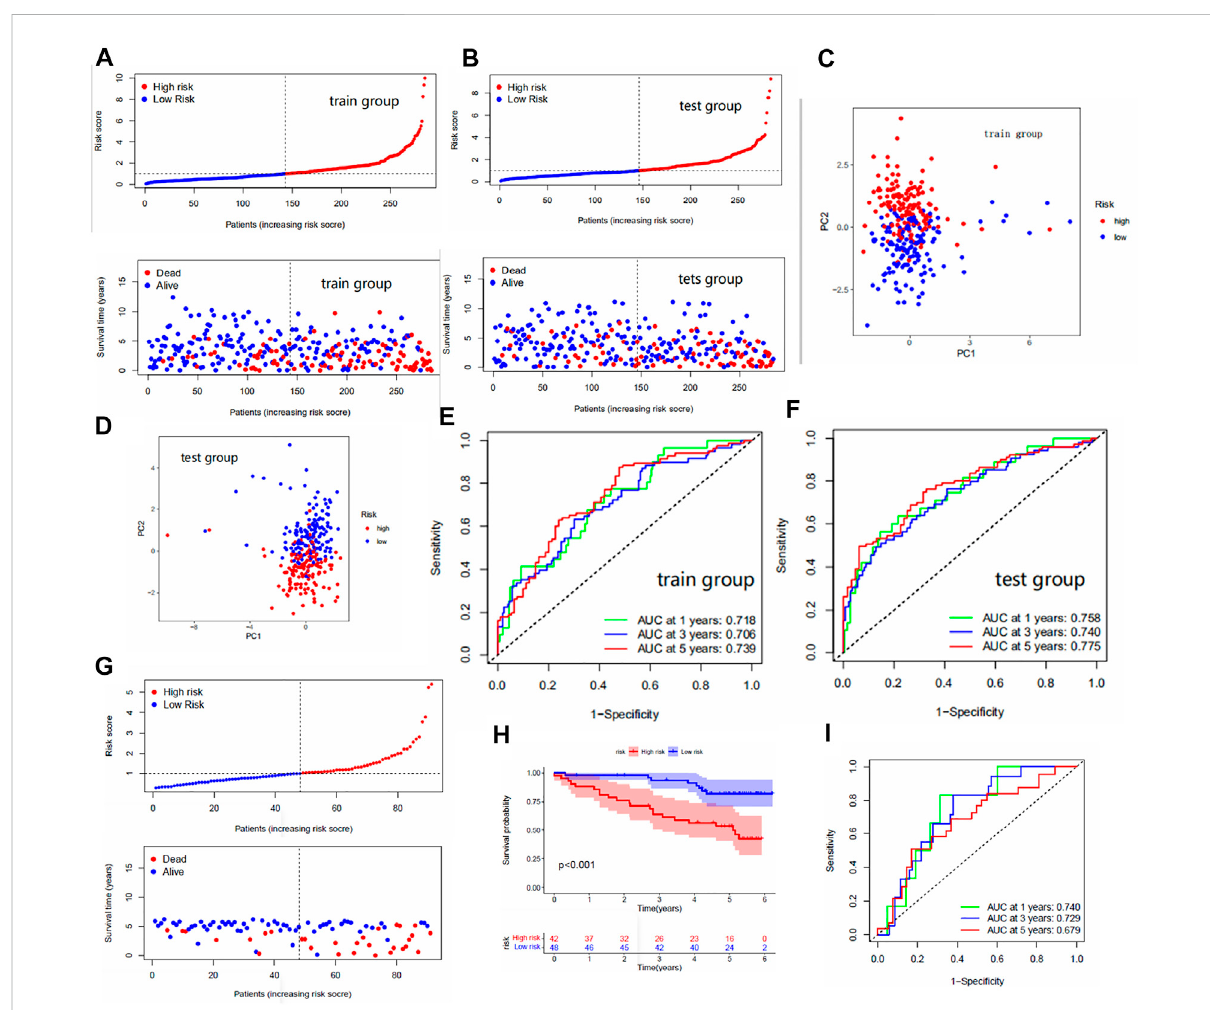
FIGURE 2 (A,B) Risk curves for the train and test groups. These include scatter plots showing risk scores and patient survival status, and ranked plots in order of increasing risk scores. (C,D) PCA results for the train/test groups. Each dot represents a patient. (E,F) The area under the ROC curve for the train/test group. The area under the ROC curve represents the accuracy of the model in predicting patient survival, where the larger the area, the highertheaccuracy. (G) RiskcurvesfortheICGCcohort. (H) TheKaplan-MeieranalysisintheICGCcohort. (I) TheareaundertheROCcurvefor the ICGC